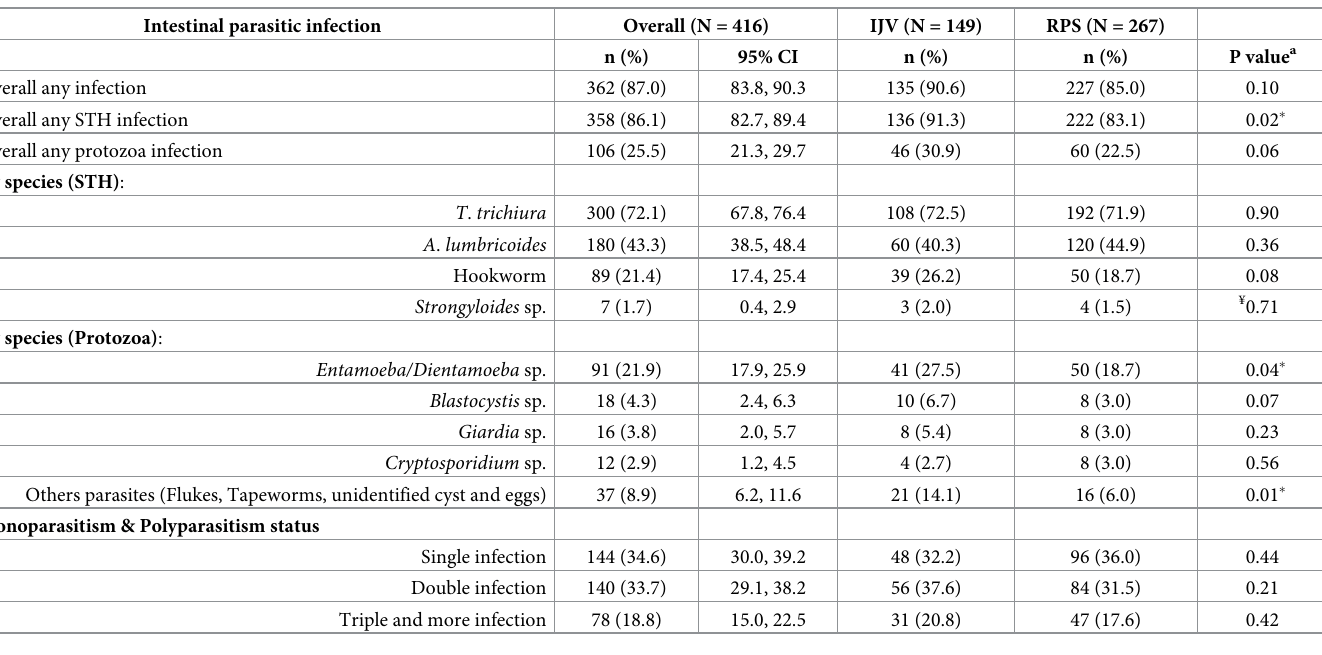
Table 3. Overall prevalence of IPIs and pattern of infections among IJV and RPS communities.